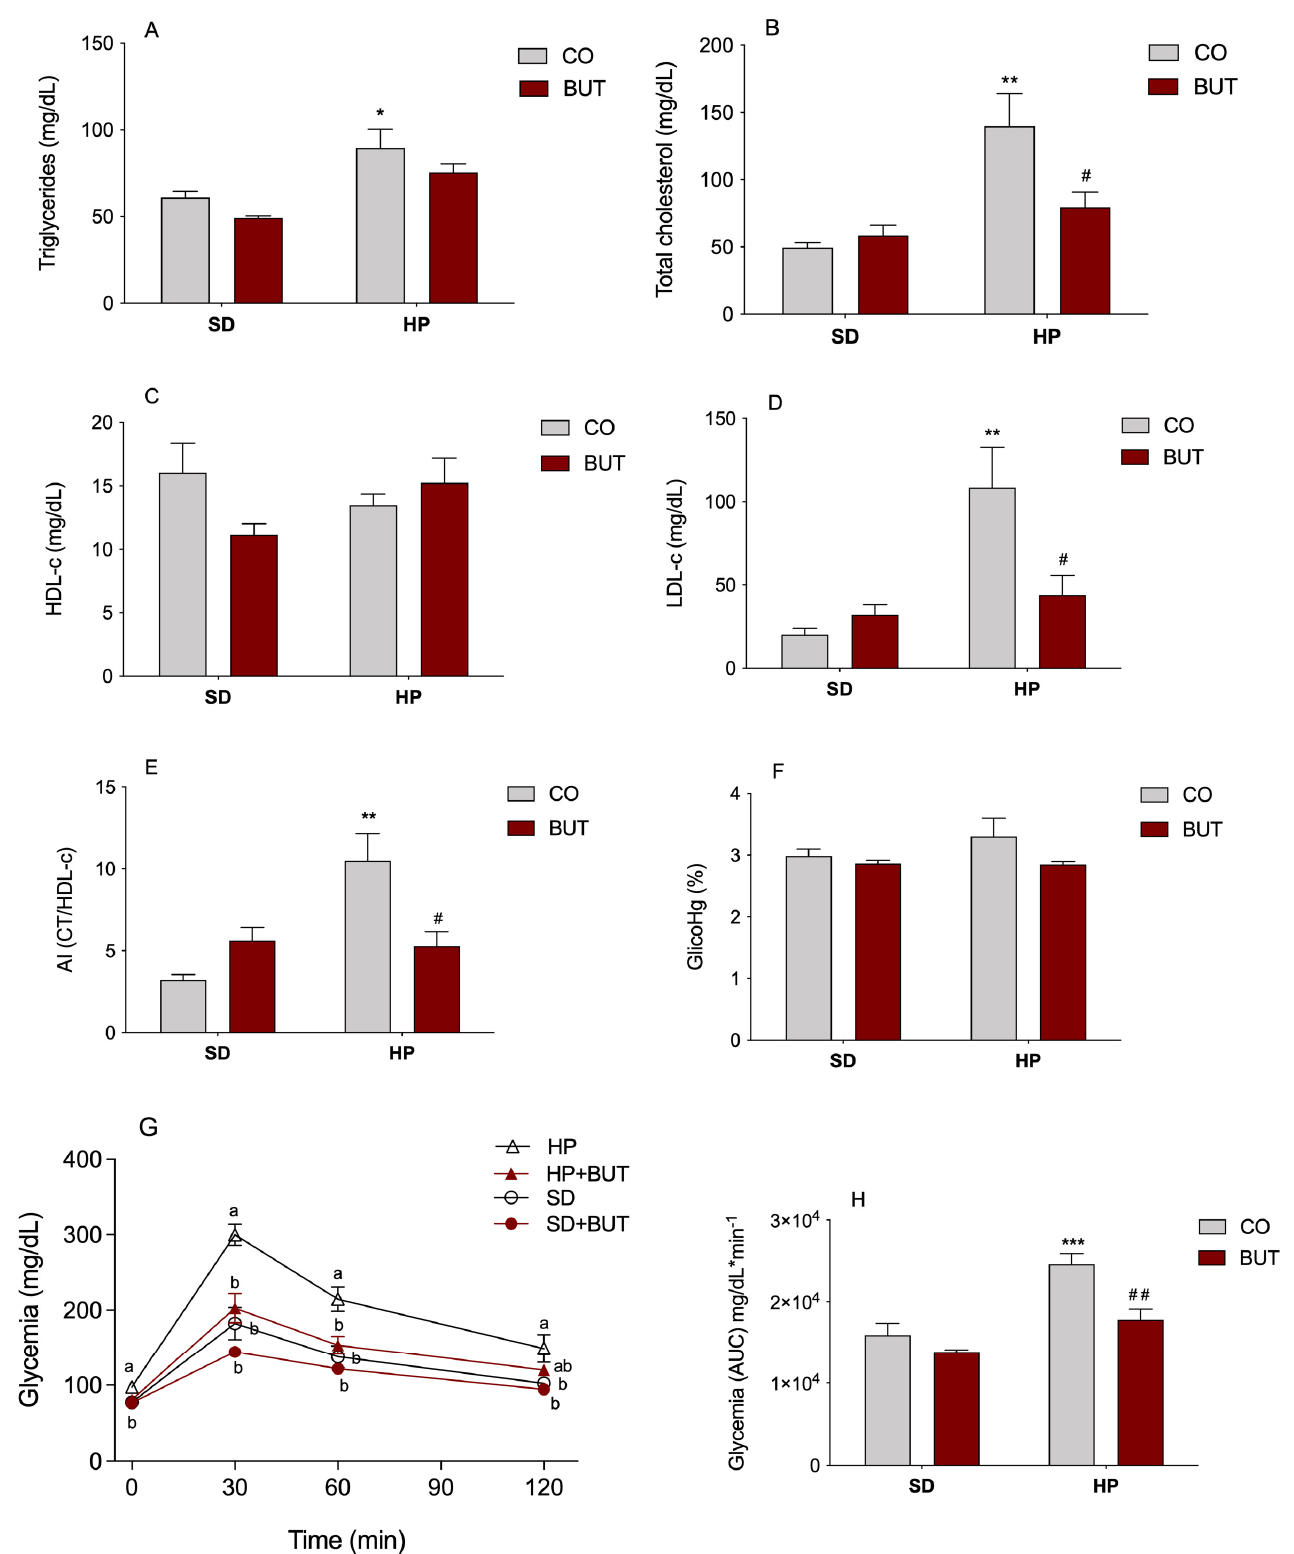
Figure 2. Effect of C. baccatum BUT extract (200 mg/kg, p.o.) in the plasma levels of: ( A ) triglycerides (mg/dL); ( B ) total cholesterol (mg/dL); ( C ) HDL-cholesterol (mg/dL); ( D ) LDL-cholesterol (mg/dL); ( E ) atherogenic index (AI) expressed as total cholesterol (CT)/HDL-cholesterol (HDL-c); ( F ) glycosylated hemoglobin (GlicoHg%); ( G ) glucose tolerance test (GGT); and ( H ) area under the curve